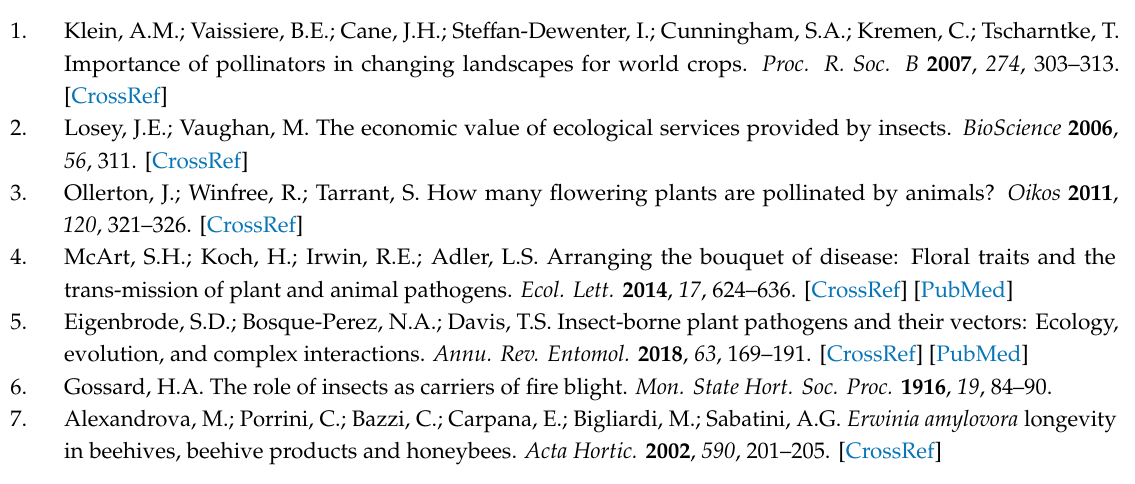
Figure S1 Proportion of bees showing the proboscis extension response to pure sugar solution or sugar solution containing P. ananatis bacteria. Repeated stimulation of the antennae of honeybee foragers does not lead to fatigue, because responses to pure sugar solutions o ff ered in between sugar solutions contaminated with di ff erent amounts of bacteria remained high until the end. Raw data corresponding to Figure